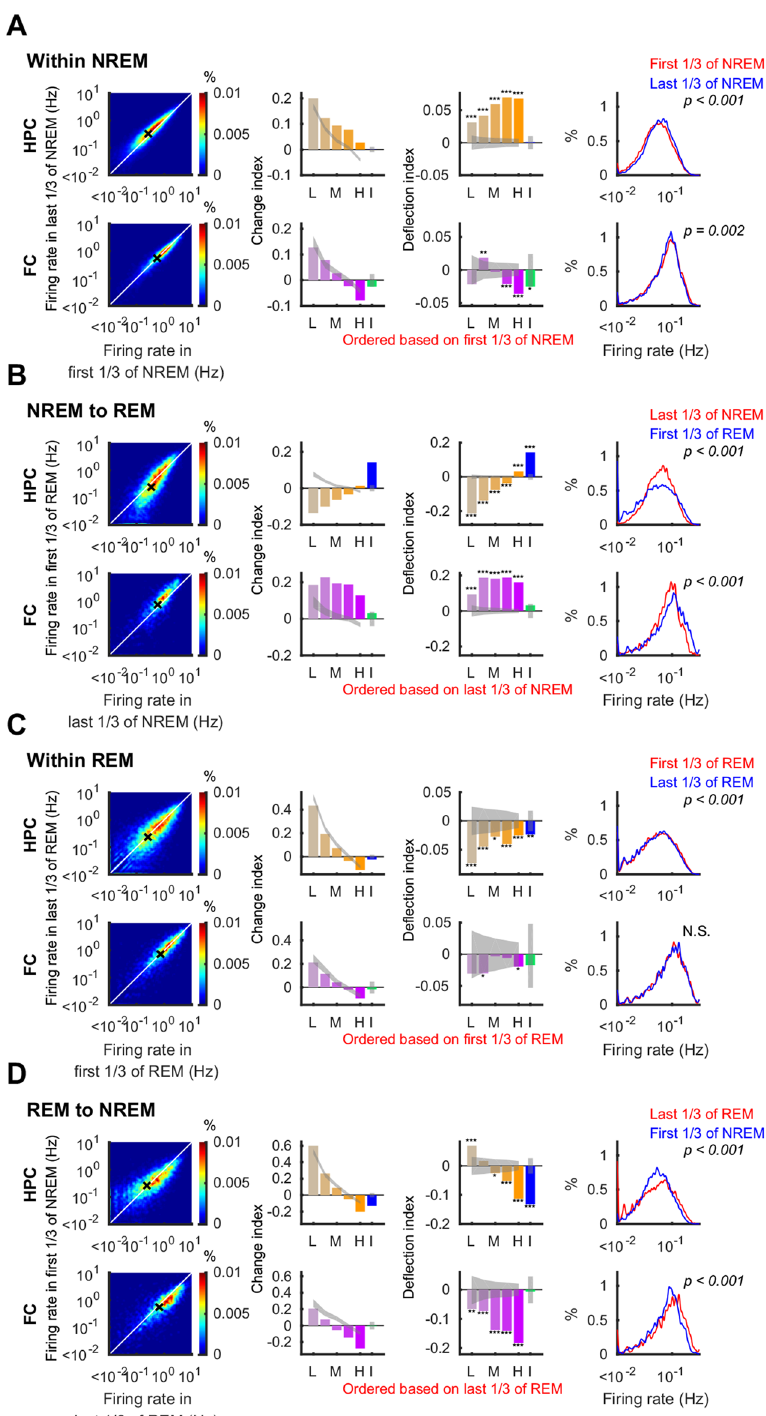
Figure 4. Firing rates diversify on transitions to REM and homogenize on transition to NREM. Firing rate changes within NREM ( A ), on transitions from NREM to REM ( B ), within REM ( C ), and on transitions from REM to NREM ( D ) in the hippocampus (HPC; top rows—orange) and the frontal cortex (FC; bottom rows— purple). Left panels show density (heat map) plots of firing rates. White lines indicate identity, and black crosses show means. Second and third panels illustrate change index ( CI ) and deflection index ( DI ) of each quintile of principal neurons (L: lowest quintile, M: middle quintile, H: highest quintile, yellow and purple bars) and interneurons (I, blue and green bars,) with 95% confidence interval (gray bands). Right panels show the firing rate distribution over all recorded principal neurons for the periods indicated in red and blue. P-values for the Kolmogorov–Smirnov test are indicated. *p < 0.05, **p < 0.01, ***p <